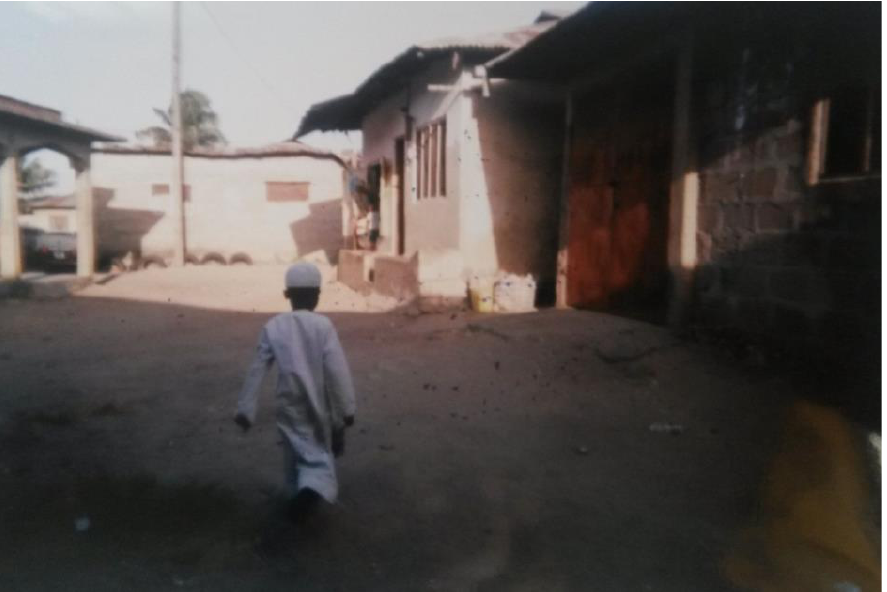
Figure 1. ‘This picture explains the right to learn at school, madrasa, or tuition. Children can learn w herever they consider to be an eligible place, and they should be given their opportunity ’ . (Zuleika, 12 years